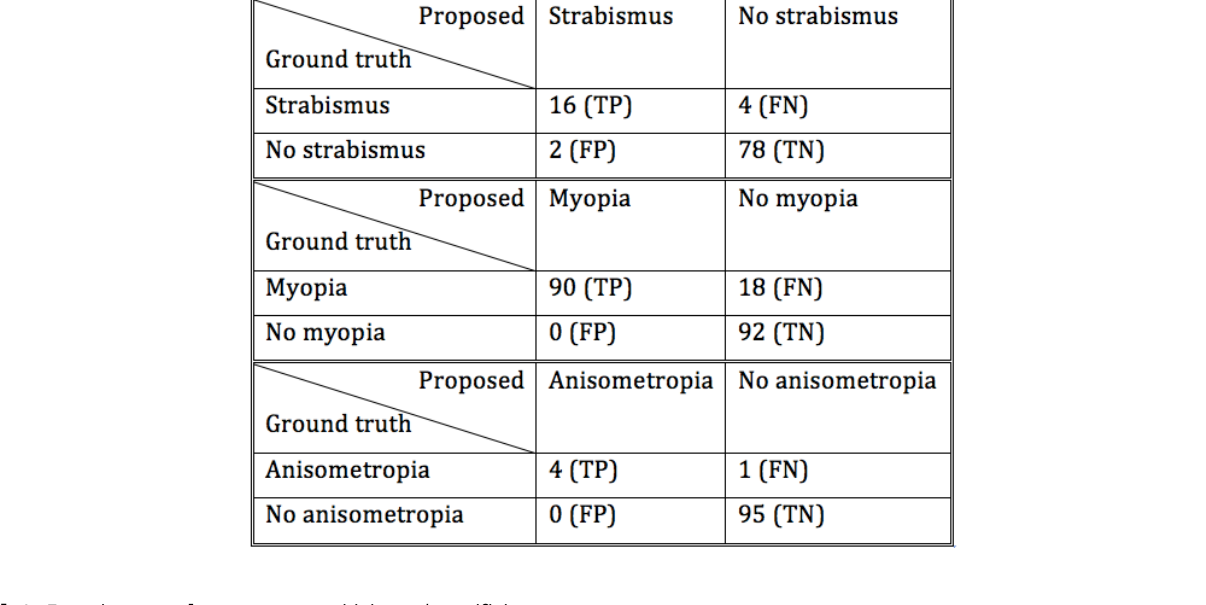
Table 1. Experiment results: accuracy, sensitivity, and